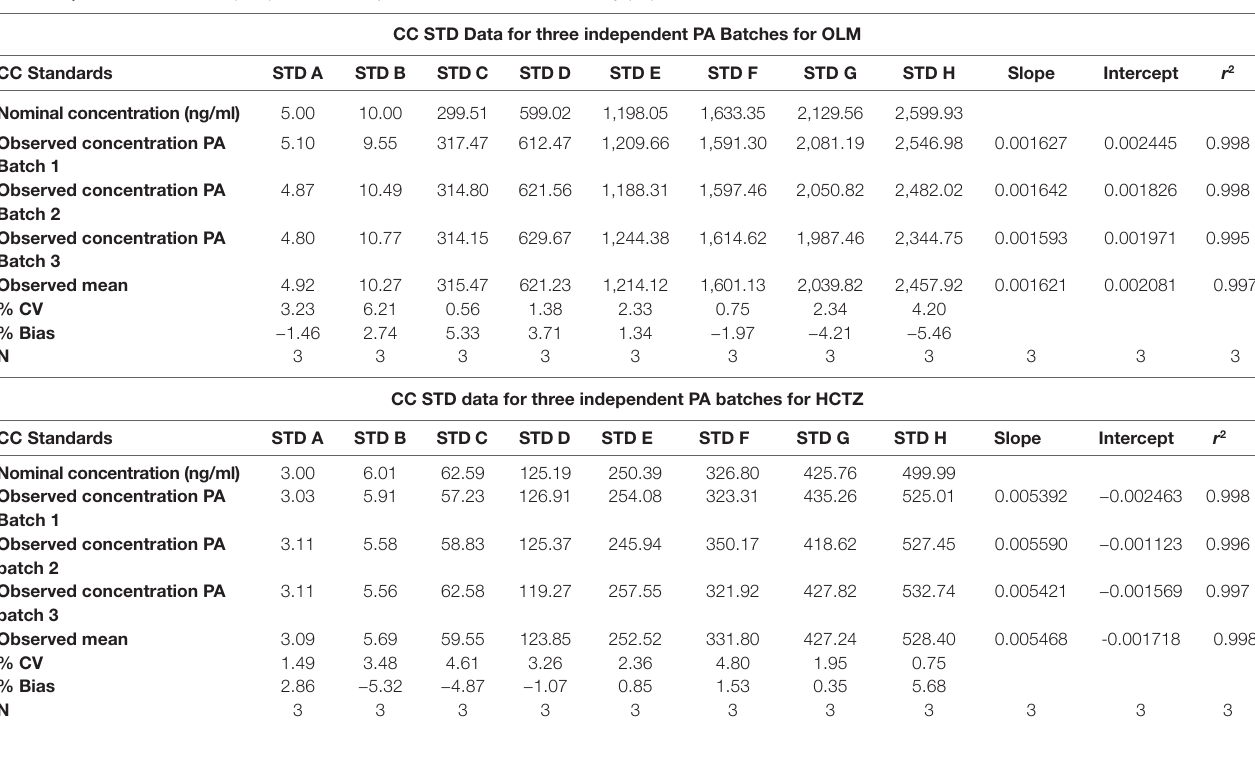
TABLE 3 | CC Standards Data (STD) for three independent Precision and Accuracy (PA)